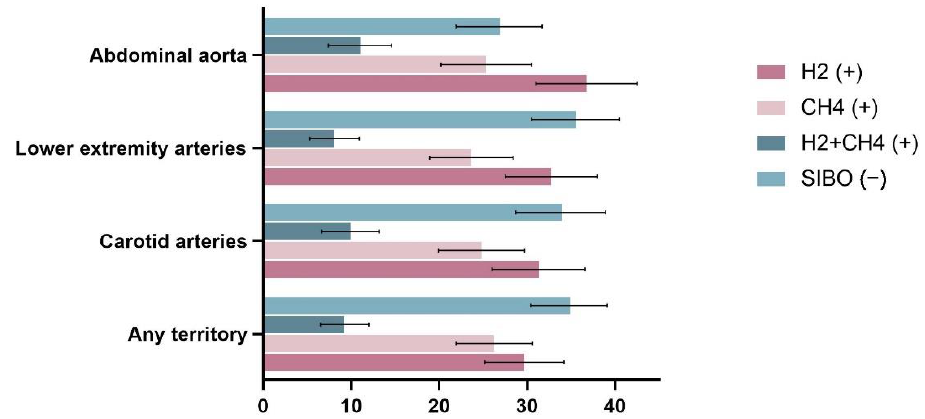
Figure 1. The prevalence of SIBO.